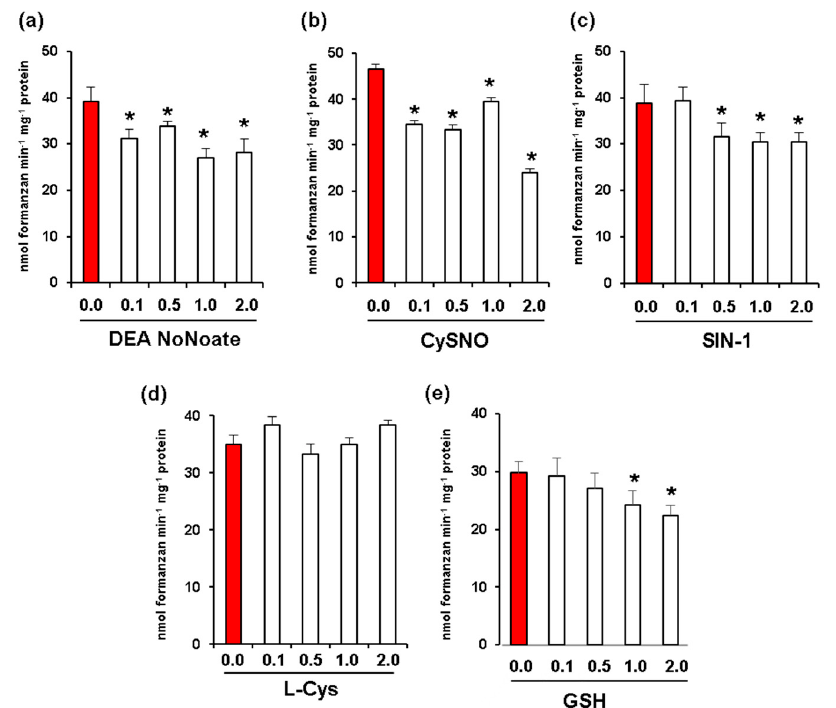
Figure 4. Effect of nitric oxide (NO) and peroxynitrite (ONOO - ) on CaRboh activity in red green pepper fruits. ( a ) Effect of diethylamine NONOate (DEA NoNoate, nitric oxide donor). ( b ) Effect of S-nitrosocysteine (CySNO, NO donor). ( c ) Effect of 3-morpholinosydnonimine (SIN-1, peroxynitrite donor). ( d ) Effect of L-cisteine (L-Cys). ( e ) Effect of glutathione (GSH). Treatments with DETA-NONOate and S -nitrosocysteine (CySNO) as NO donors, L-Cys and GSH were done by incubating the pepper samples with these compounds at 25 ◦ C for 1h. In the case of SIN-1, the assay was done at 37 ◦ C for 1 h. Data represent the mean ± SEM of at least three independent biological replicates. Asterisks ( * ) indicate significant differences ( p < 0.05) in comparison to the